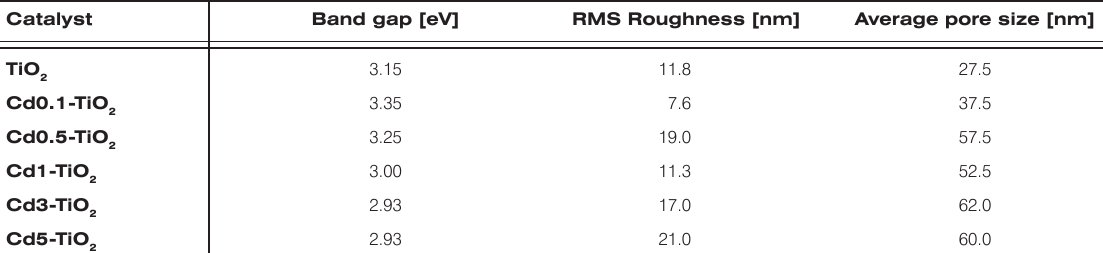
Figure 2. The AFM image for the films:(a) TiO Table 1. The properties of cadmium modified